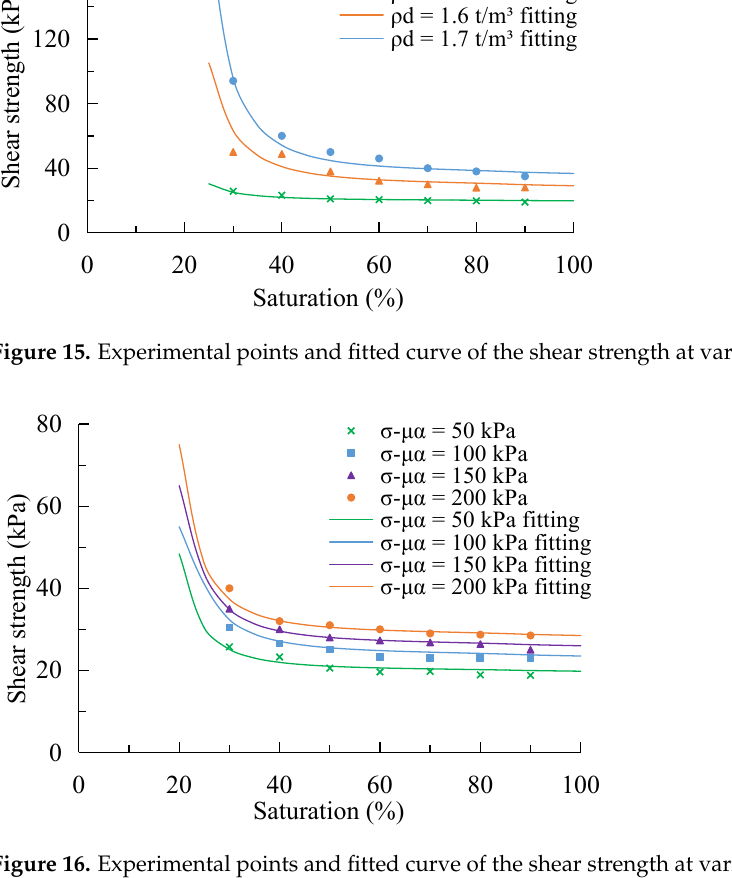
Figure 16. Experimental points and fitted curve of the shear strength at various net normal stresses.